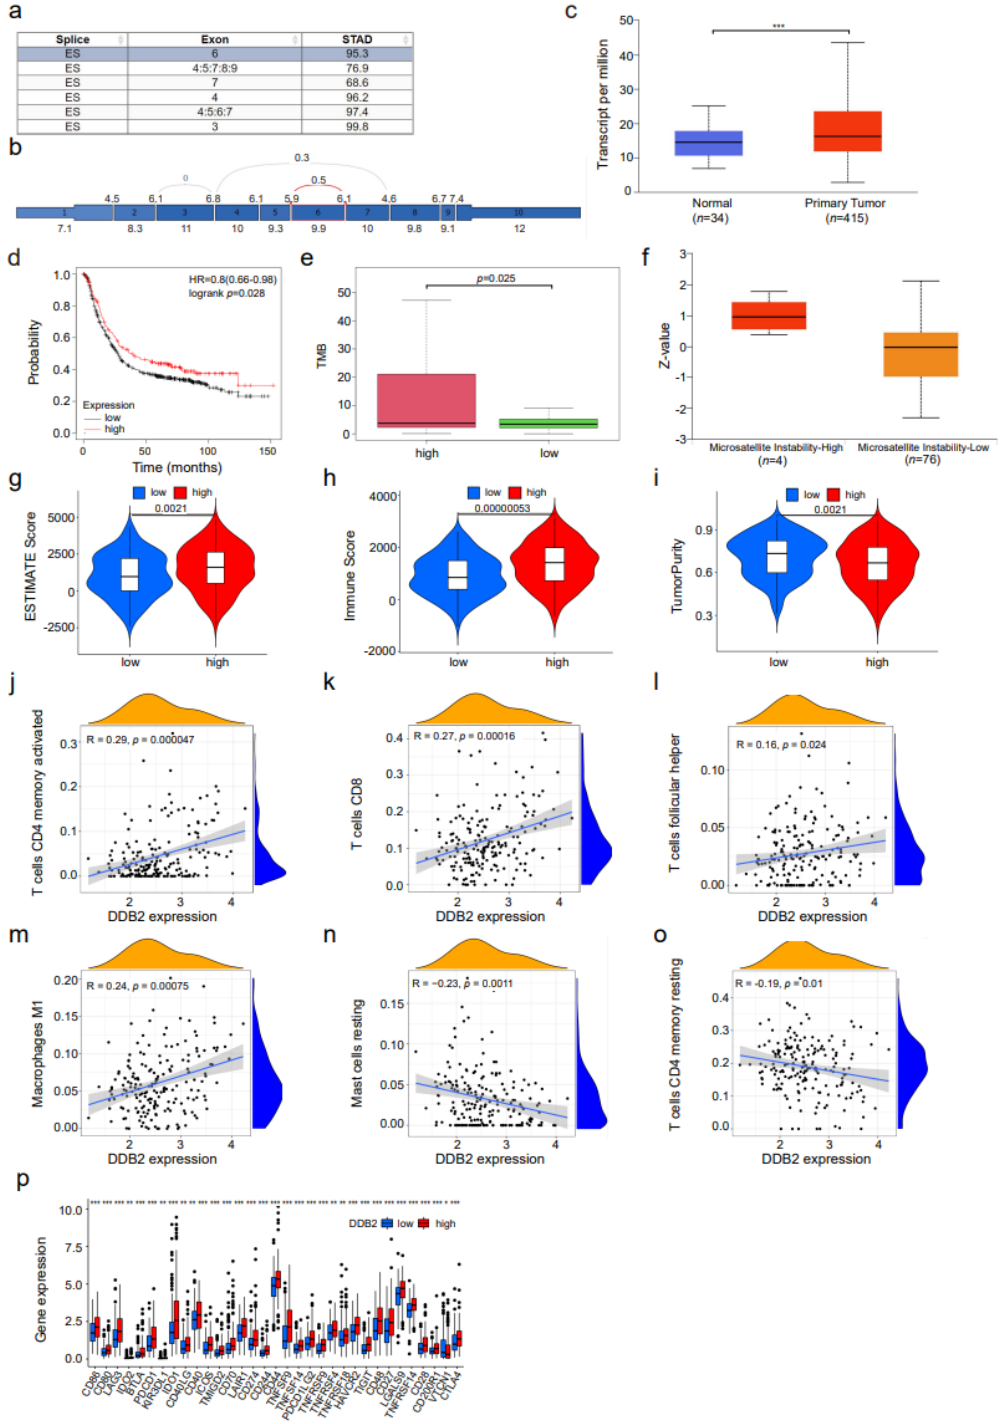
Figure 7. DDB2 could be the potential prognostic biomarker in STAD patients with active immune responses and better survival. ( a ) Results table shows DDB2 splicing type, exon, and average PSI values for STAD in the TCGA SpliceSeq. ( b ) A splice graph of the DDB2 ’s exons were shaded based on expression level and shows the selected splice event outlined in red. ( c ) The mRNA expression level of DDB2 between STAD tumor tissues and neighboring ordinary tissues in UALCAN dataset. ( d ) Kaplan–Meier curves of OS for patients with high and low DDB2 expression. ( e ) TMB score of DDB2 for STAD patients between high and low DDB2 expression. ( f ) Comparisons of MSI-H and MSI-L STAD tumors between high and low DDB2 expression in the UALCAN dataset. ( g – i ) The ESTIMATES score, immune score, and tumor purity between the low DDB2 expression group and